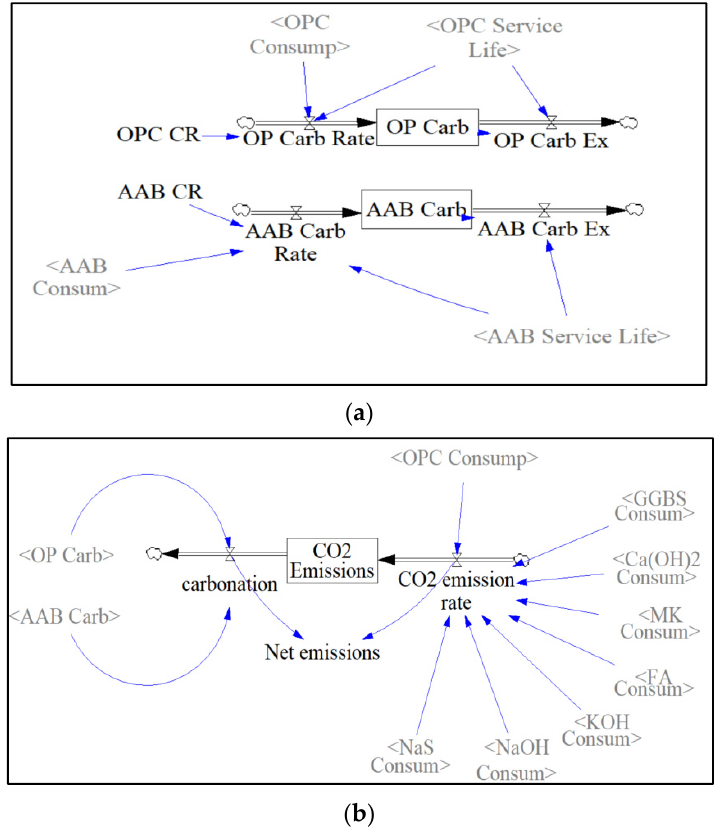
Figure 9. ( a ) Carbonation Sector; ( b ) CO 2 Emissions Sector.